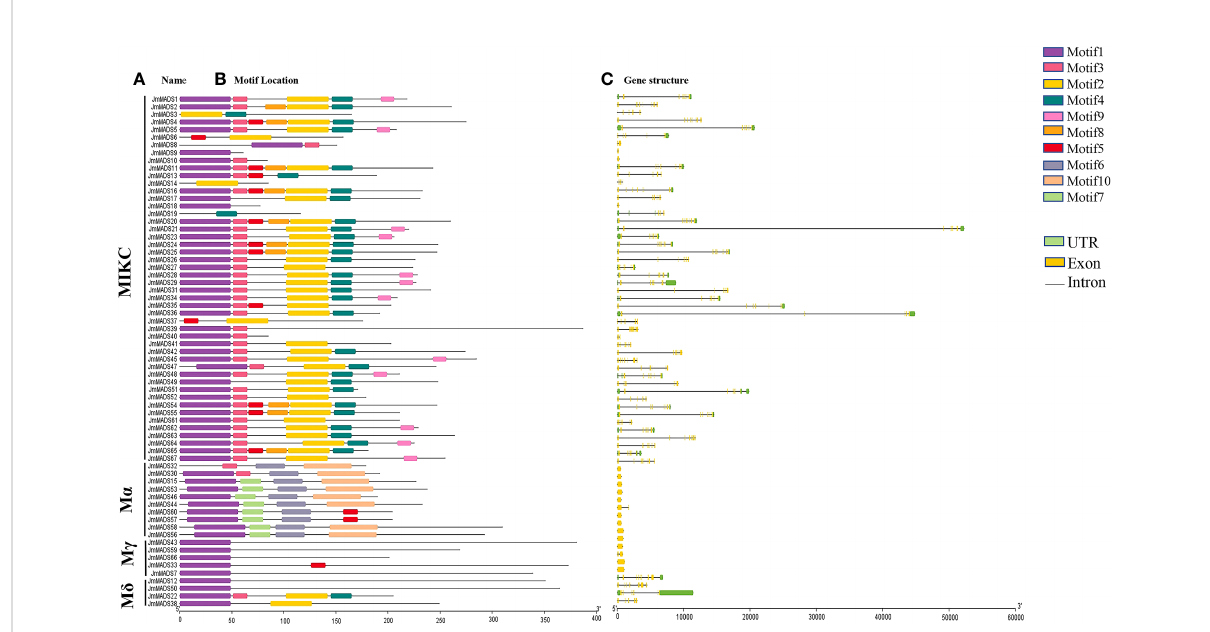
FIGURE 2 Analysis of gene structure and protein motifs. (A) The names of the JmMADS genes. (B) The motifs of the JmMADS proteins. Motifs 1 – 10 are displayed using different colored boxes listed. (C) The gene structure of JmMADS genes. Yellow boxes represent exons, black lines indicate introns, and green boxes represent the untranslated 5 ′ and 3 ′